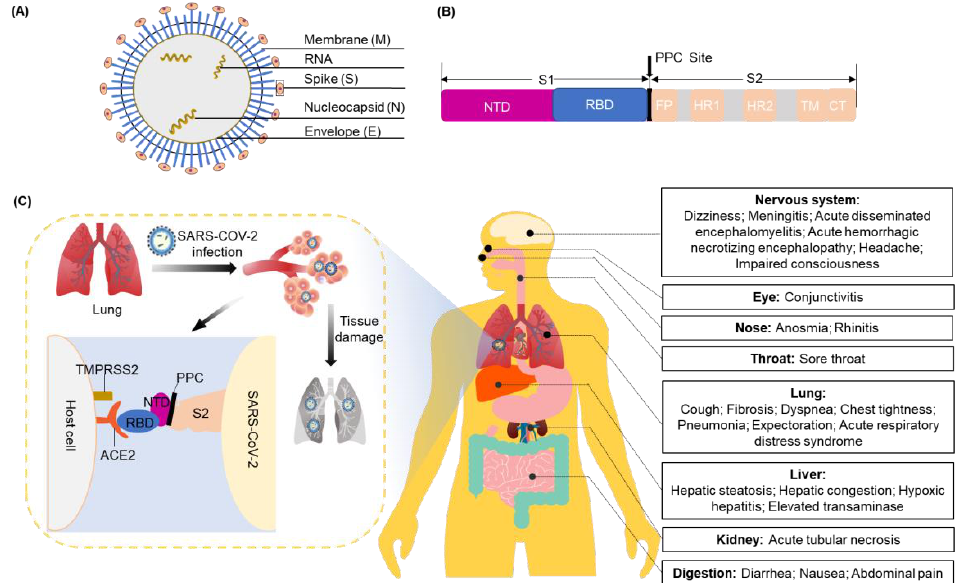
Figure 1. The infection of SARS-CoV-2 into human cells. ( A ) Structure of SARS-CoV-2; ( B ) structure of the S protein. S1 includes an NTD and RBD. S2 plays a role in promoting cell entry in membrane fusion and contains an FP domain, two seven-step repeat domains (HR1 and HR2), a TM domain, and a CT domain; ( C ) schematic representation of the infection of SARS-CoV-2 into human cells and toxic effects. S protein: spike protein; NTD: N-terminal domain; RBD: receptor-binding domain; FP: fusion peptide; TM: transmembrane; CT: C-terminal; SARS-CoV-2: severe acute respiratory syndrome coronavirus